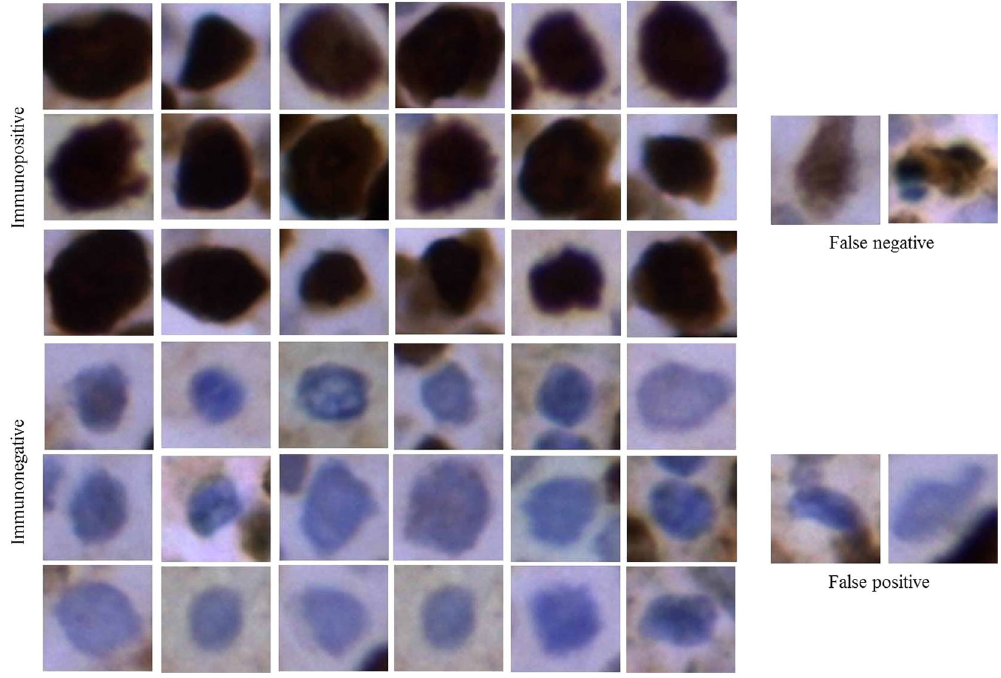
Figure 8. Ki-67 detection results by using the proposed algorithm.